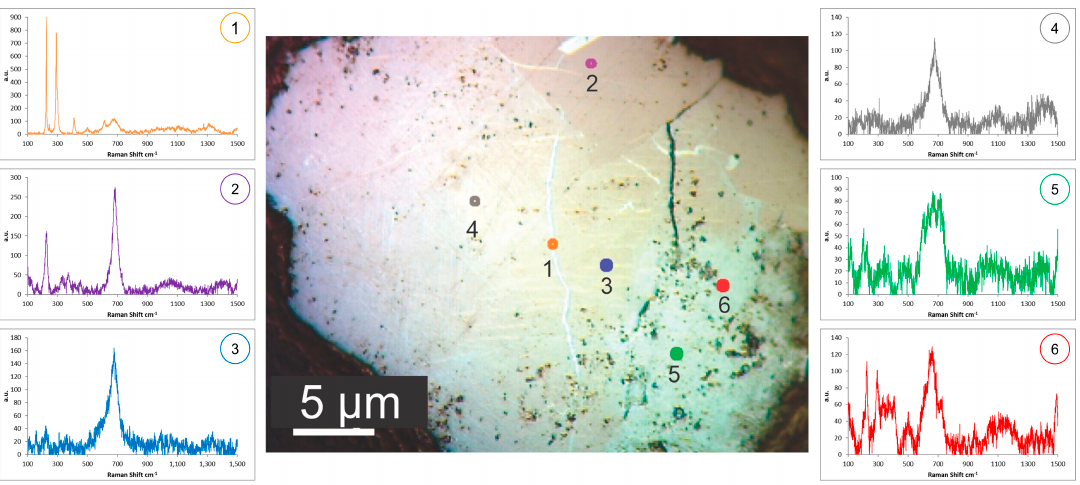
Figure 3. Gua í ra soil particle observed by reflected light microscopy, and Raman spectra with diagnostic vibrations of (1) hematite (225, 293, 415, 500, 618 cm − 1 ); (2) ilmenite (225, 390, 670 cm − 1 ); (3,4) nonstoichiometric magnetite (675 cm − 1 ); (5) maghemite (667, 720 cm − 1 ); (6) maghemite and goethite intergrowth (243, 293, 385, 399, 470, 547 cm − 1